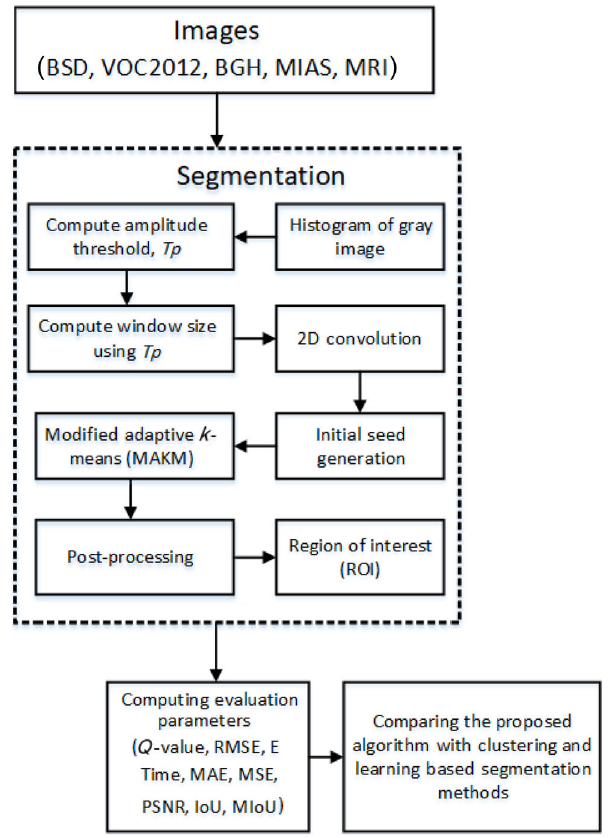
Fig. 1 Flowchart of our convolution-based segmentation algorithm. First, histograms of the grayscale image of the original image are generated. Second, amplitude thresholds, Tp , are computed using the histogram levels. Third, the dynamic window size is computed using an amplitude threshold for each image. This is followed by a 2D convolution operation. Finally, the mean of the convolution is set as the initial seed to generate other new seed values that can be used as the centers of clusters, which are then used to perform